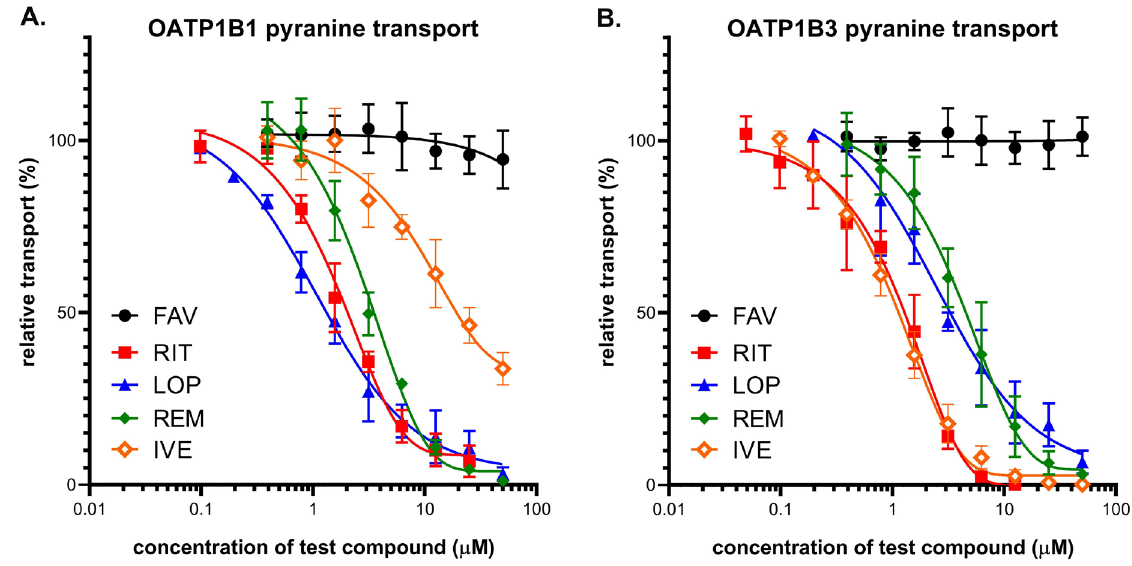
Figure 3. Inhibition of OATP1B1 (Panel A ) and OATP1B3 (Panel B ) dependent pyranine uptake in transporter overexpressing A431 cells by repurposed anti-COVID agents. Cells were incubated with 10 µM (OATP1B1) or 20 µM (OATP1B3) pyranine in the presence or absence of increasing concentrations of anti-COVID agents at 37 °C for 15 or 30 min (OATP1B1 or OATP1B3, respectively). Average values of 3 independent experiments +/− SD are shown.